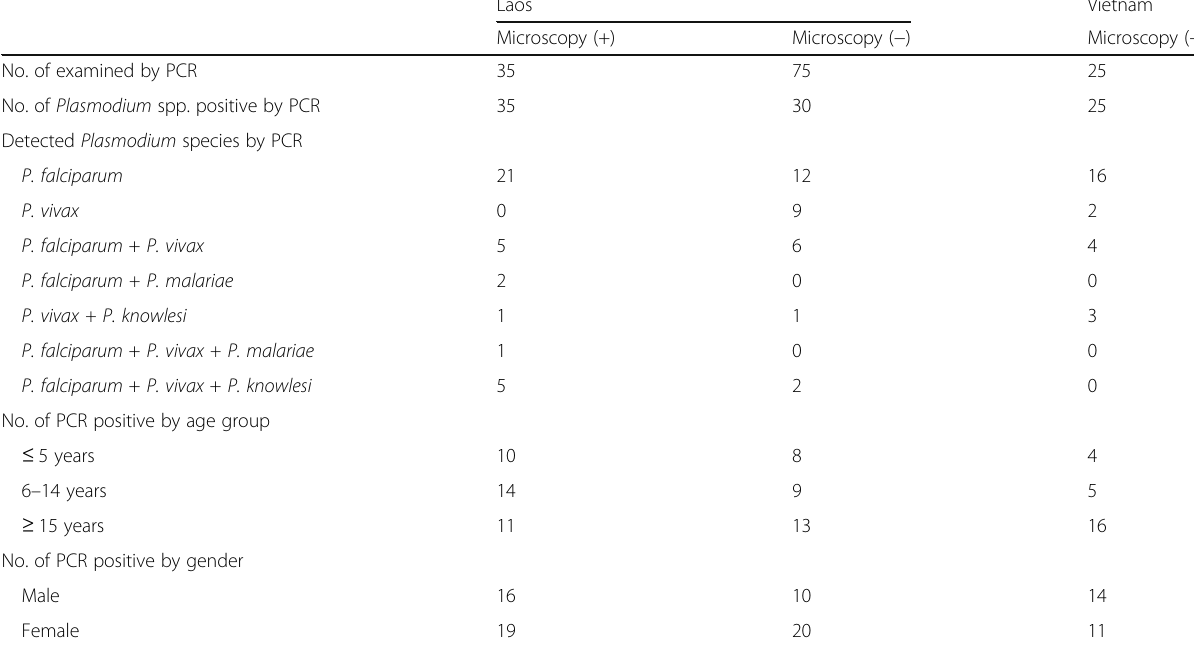
Table 2 Summary Plasmodium species of human blood collected Laos and Vietnam by PCR analysis Laos Vietnam Microscopy (+) Microscopy ( − )